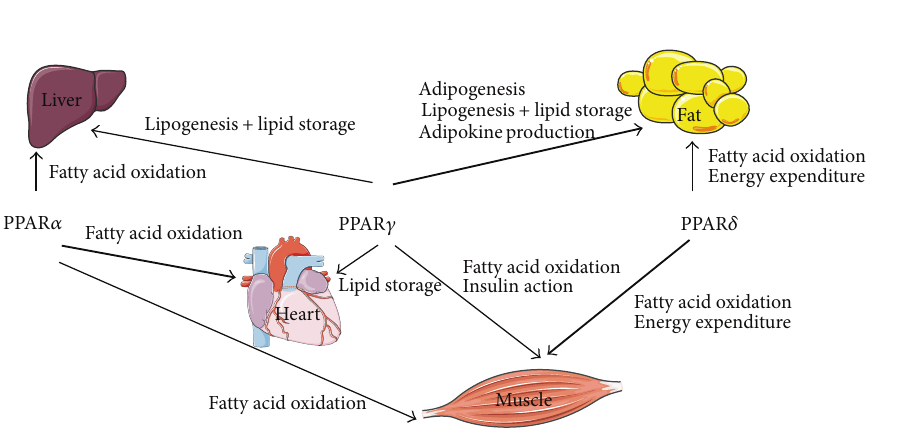
Figure 1: Metabolic regulation by PPARs. The different PPAR isoform regulates fatty acid and lipid metabolism in liver, heart, skeletal muscle, and adipose tissue. Figures were produced using Servier Medical Art (http://www.servier.com/).